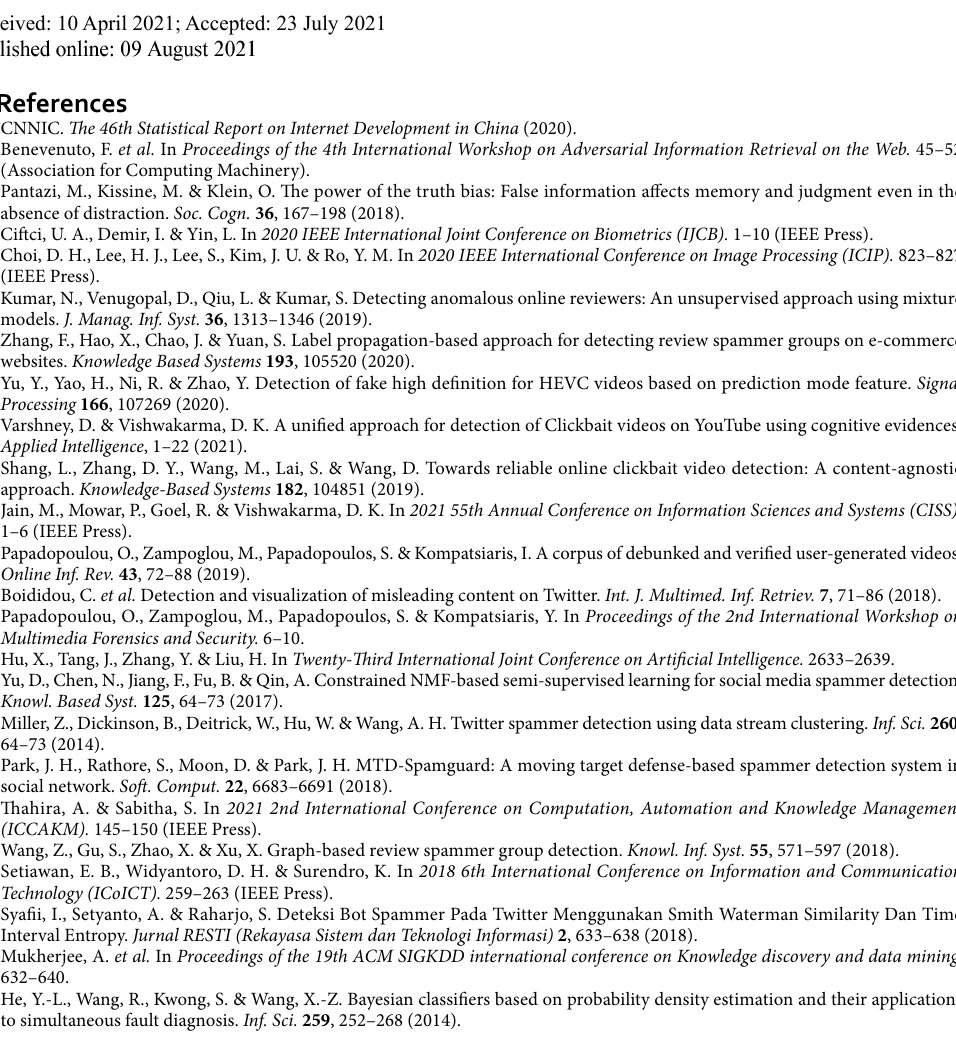
Figure 5. Comparison of classification results by the Naive Bayesian model based on different feature